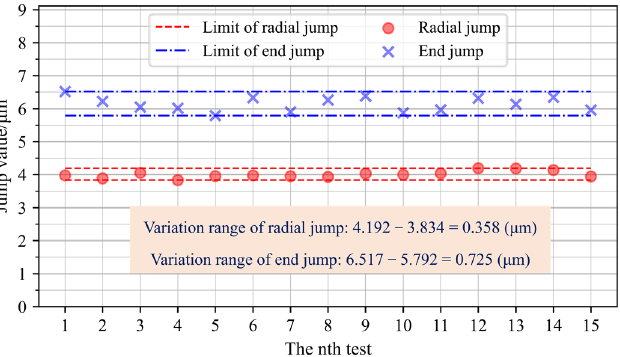
Figure 12. Test results of experimental group 1 without rotating teeth.